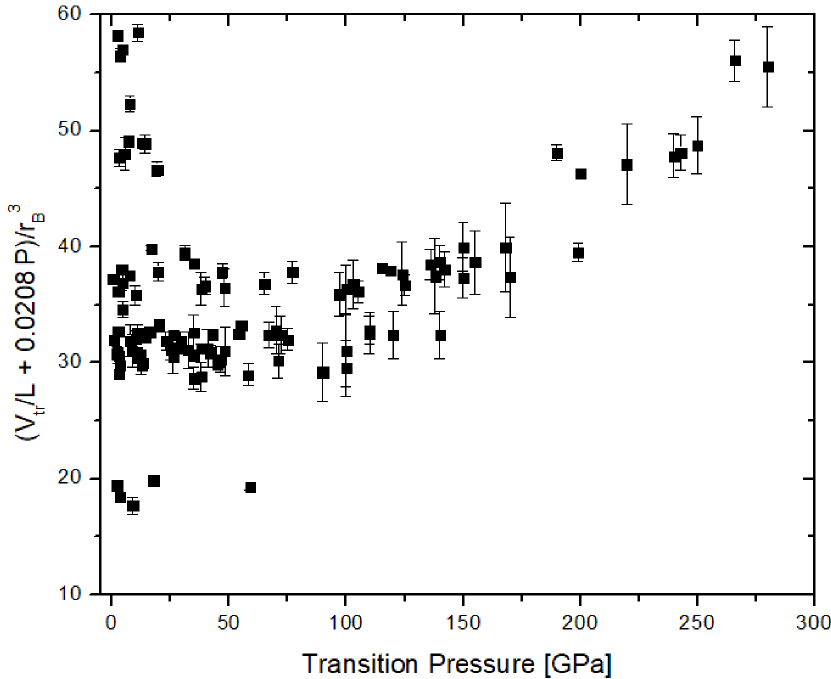
Figure 1. Volume of elemental polymorphs in Å 3 /at at 300 K divided by the principal quantum number L as a function of pressure in GPa. The volumes are those that are observed at the pressure of their formation through direct phase transformation from lower pressure polymorphs; the plotted pressures are the pressures of the transformation. The linear relation between these volumes and pressures and the existence of five distinct sets of pressure–volume relations is clearly visible.